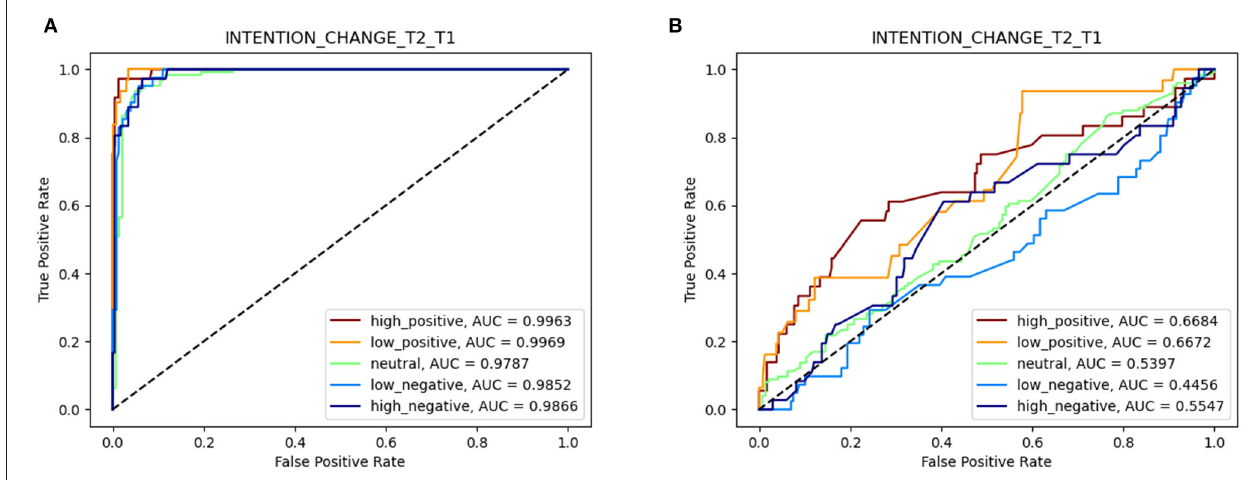
FIGURE 4 | Multivalued ROC curves obtained for the elicited DBN. elicited DBN. (A) In-sample ROCs. (B) Out-of-sample